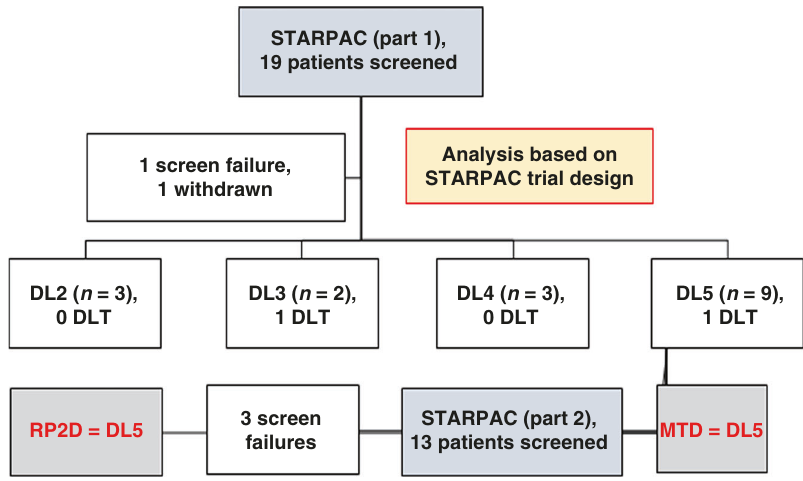
Fig. 1 CONSORT diagram for STARPAC clinical trial. Number of patients at all dose levels (DL) in dose escalation, part 1 (using the STARPAC adaptive trial design 13 ) for maximum tolerated dose (MTD) estimation, showing dose-limiting toxicity (DLT) and dose expansion (part 2) of the trial for optimal biological dose (OBD) estimation leading to recommended phase 2 dose